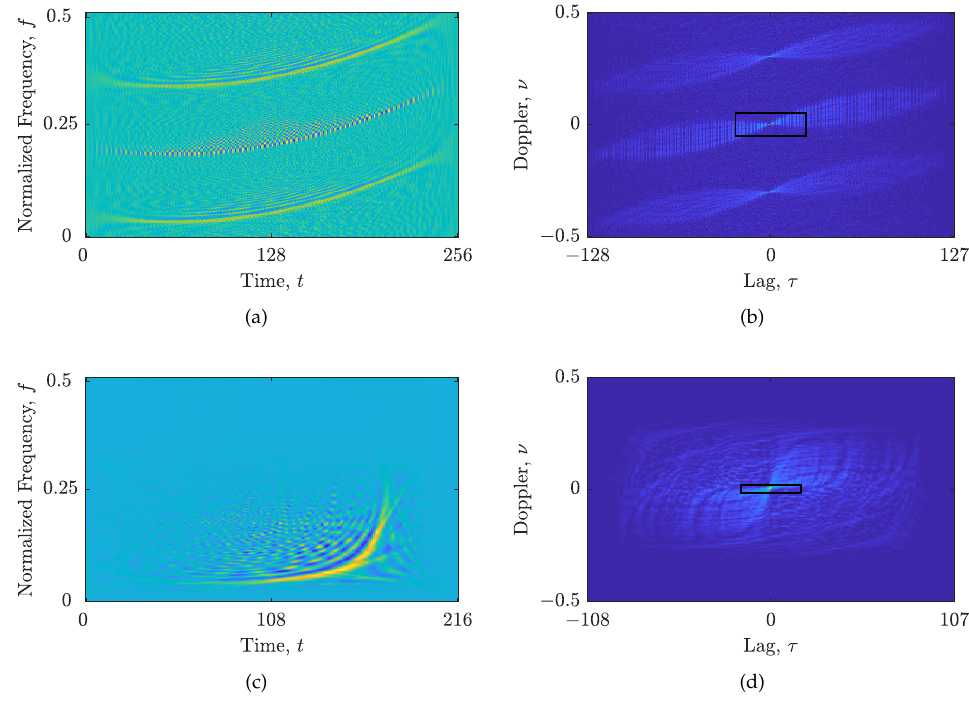
Figure 1. Considered signals: ( a ) WVD of z SS ; ( b ) AF of z SS , N (cid:48) τ = 49, N (cid:48) ν = 53; ( c ) WVD of z RS ; ( d ) AF of z RS , N (cid:48) τ = 35, N (cid:48) ν = 15. The automatically selected N (cid:48) τ × N (cid:48) ν AF area is marked by a